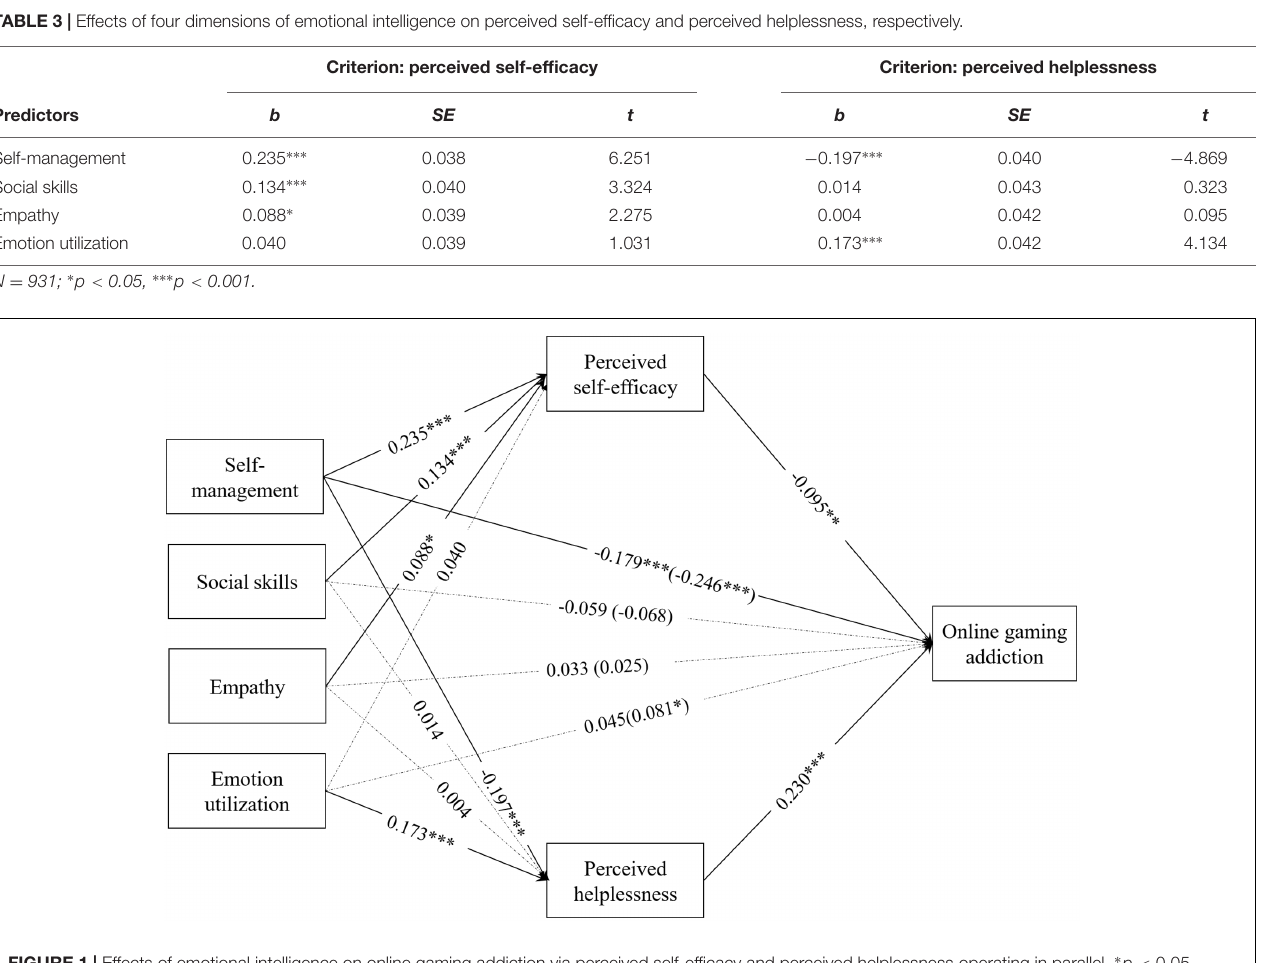
FIGURE 1 | Effects of emotional intelligence on online gaming addiction via perceived self-efficacy and perceived helplessness operating in parallel. ∗ p < 0.05, ∗∗ p < 0.01, ∗∗∗ p <